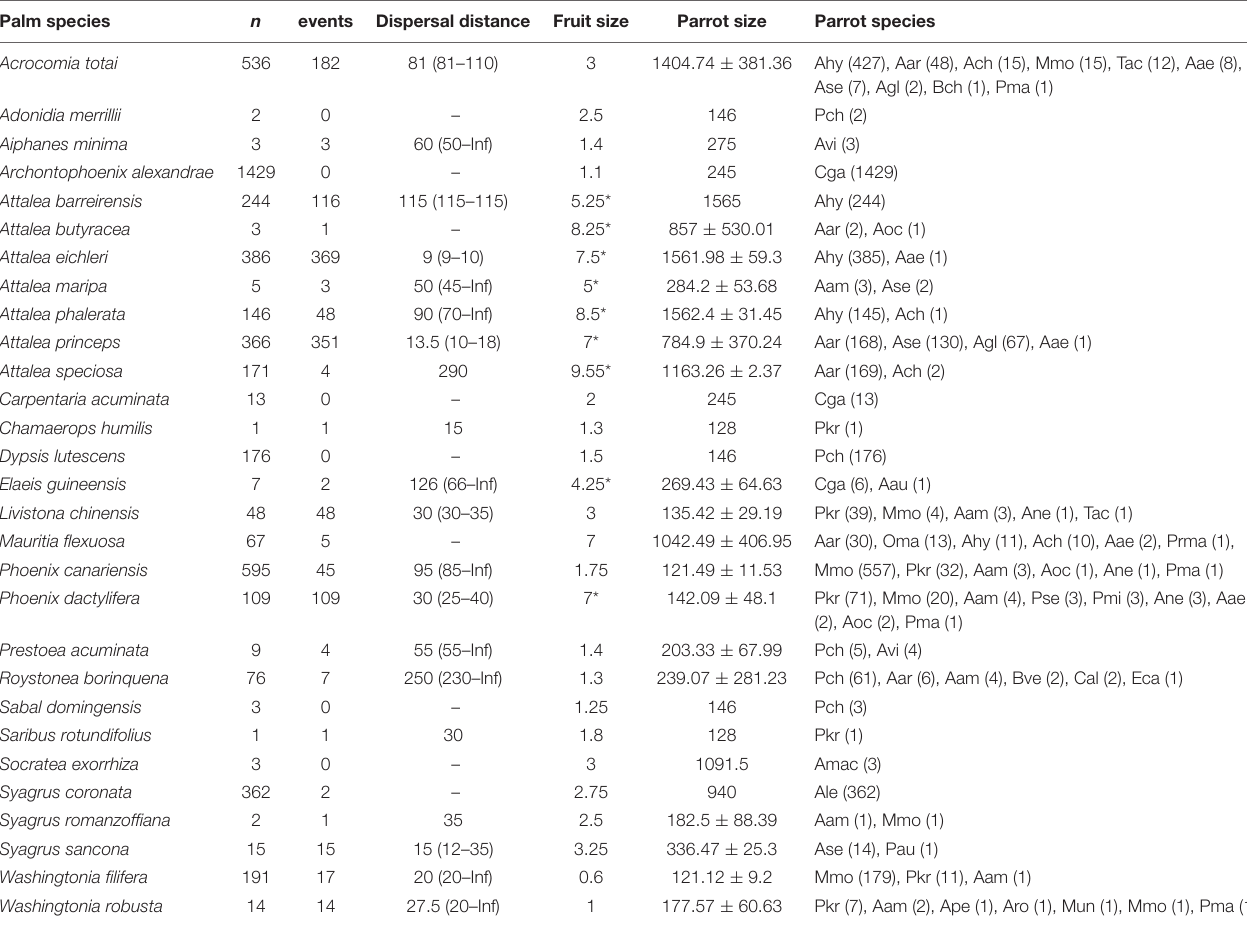
TABLE 3 | Median distances (and 95% credible intervals) at which parrots of different sizes (mean body mass ± SD of individuals dispersing each palm species; in g) can disperse different palm species varying in their fruit size (estimated as fruit length; in cm). Palm species n events Dispersal distance Fruit size Parrot size Parrot